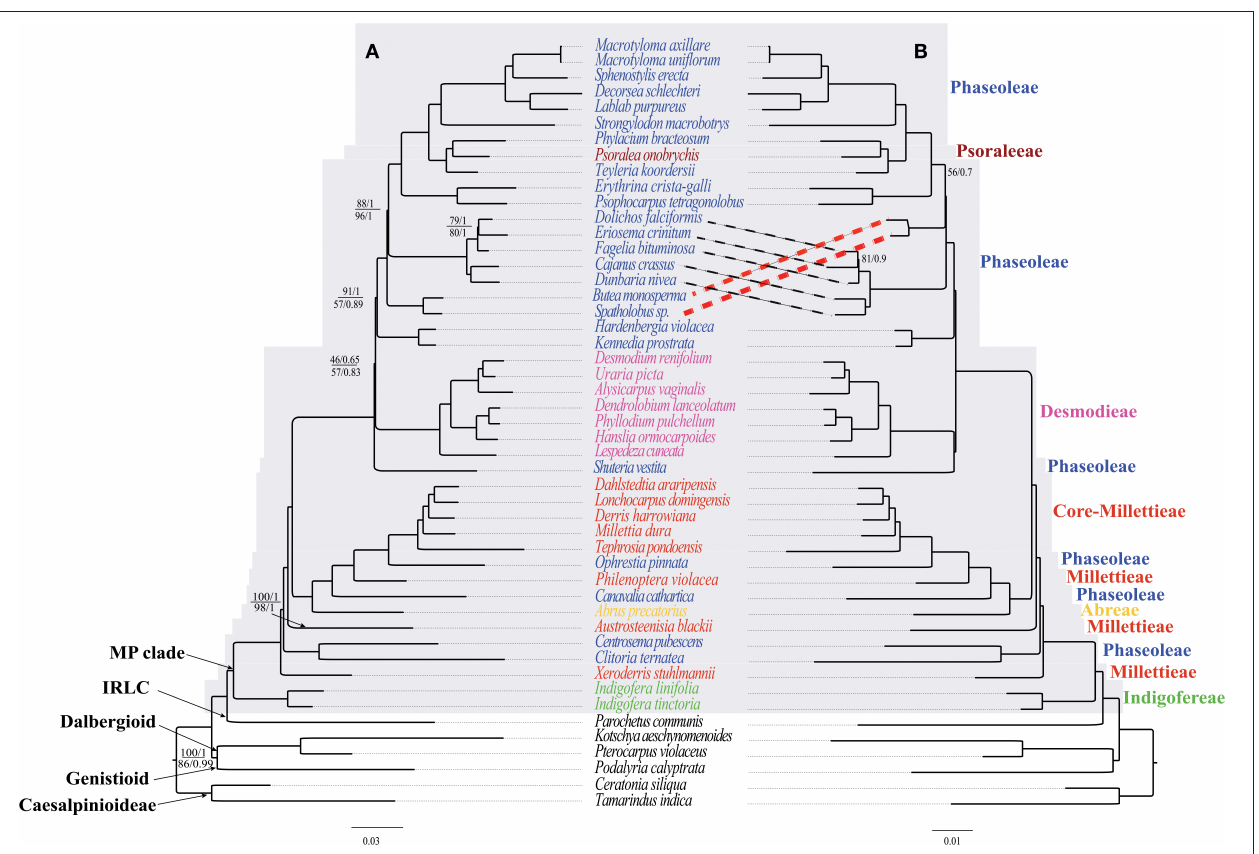
FIGURE 4 | The ML and BI phylogenetic relationships reconstructed for the MP clade. (A) CP and NCDs, and (B) CDs. Numbers at nodes correspond to ML bootstrap percentages (only values < 100% are shown) and Bayesian inference (BI) posterior probabilities (only probabilities < 1.0 are shown). For (A) , the values above and below the line represents support values for the CP and NCDs, respectively. The thick dotted lines indicate topology differences. The scale bar represents the mean nucleotide substitutions per site along the